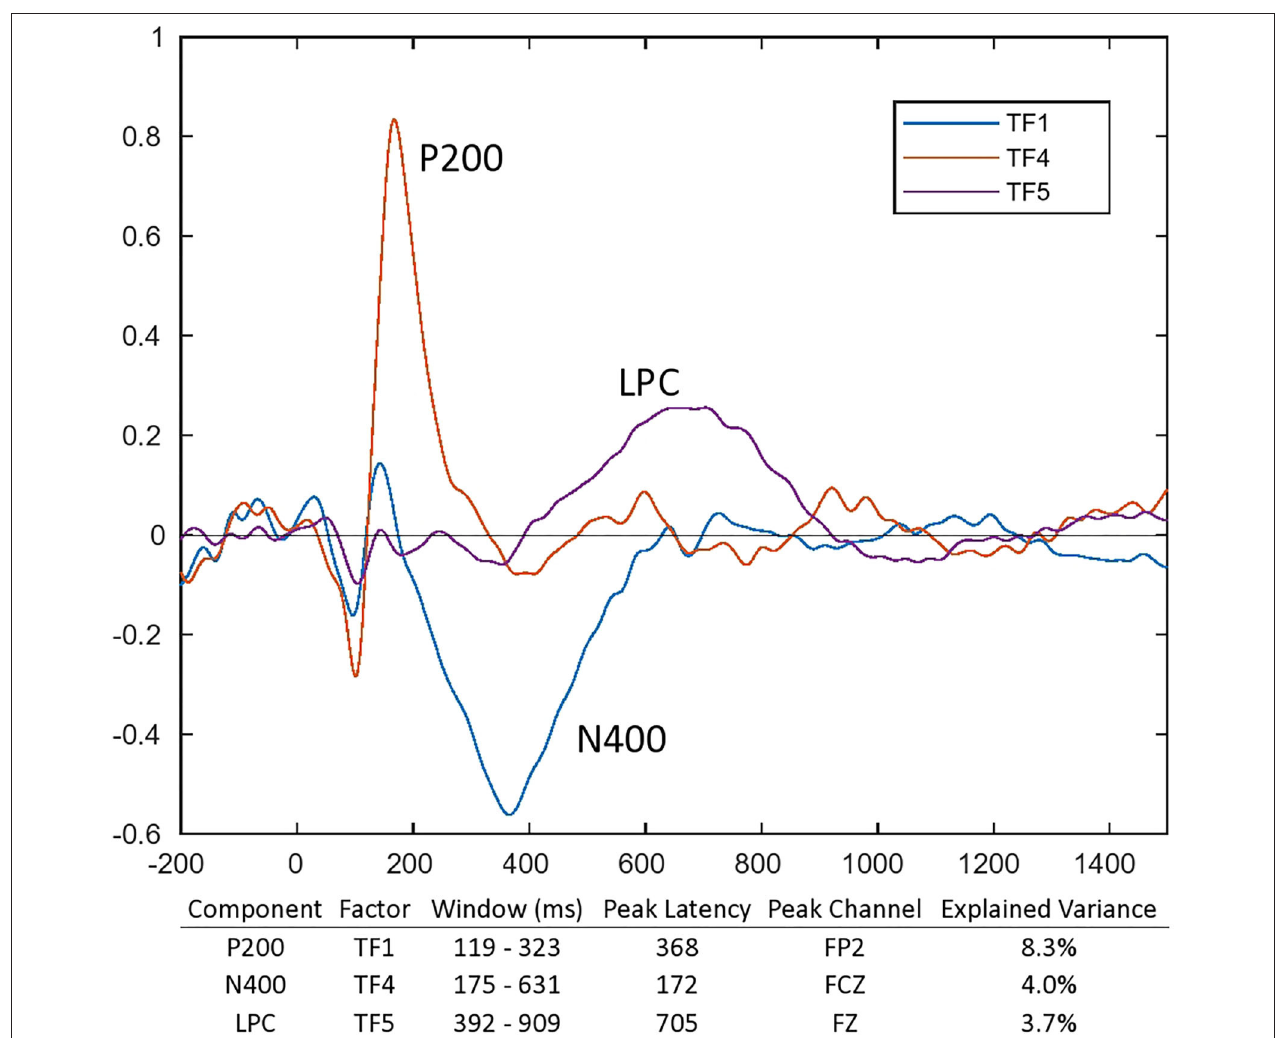
FIGURE 3 | ERP waveforms and temporal factors identified based on the temporal principal component analysis. After temporal PCA, three out of the seven temporal components conformed to P200, N400, and LPC. TF denoted temporal